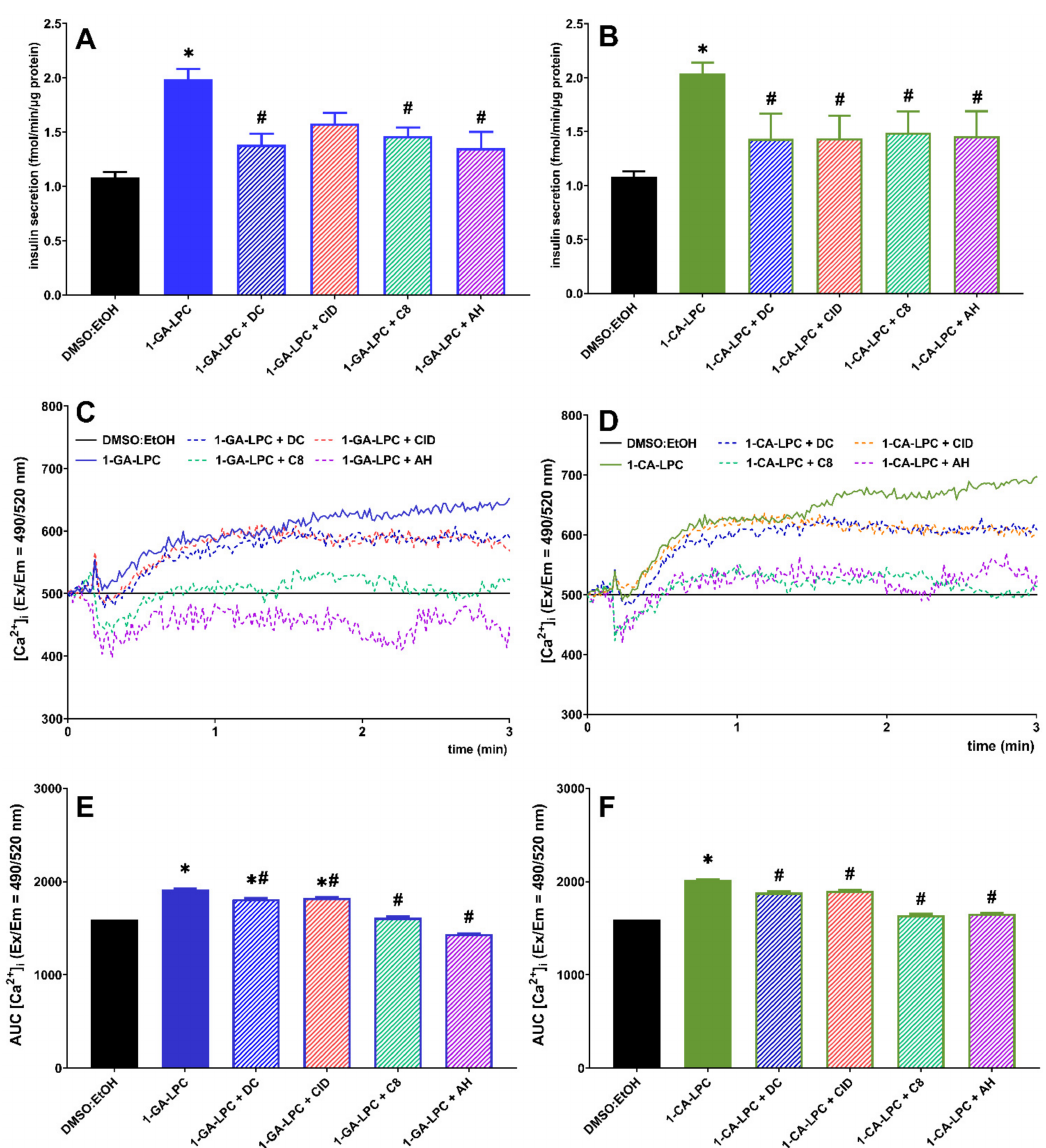
Figure 5. Insulin secretion ( A , B ) and intracellular Ca 2+ mobilization ( C – F ) in MIN6 at 20 mM glucose conditions triggered by 1-GA-LPC ( A , C , E ) and 1-CA-LPC ( B , D , F ) against GPR40, GPR55, GPR119, and GPR120 antagonists (depicted as DC, CID, C8, and AH respectively). The results are presented as means ± SEM from 4 independent experiments, 4-6 biological replicates each. p < 0.05 was estimated as significantly different from DMSO:EtOH control (*) and from MIN6 cells untreated with receptor antagonists ( #